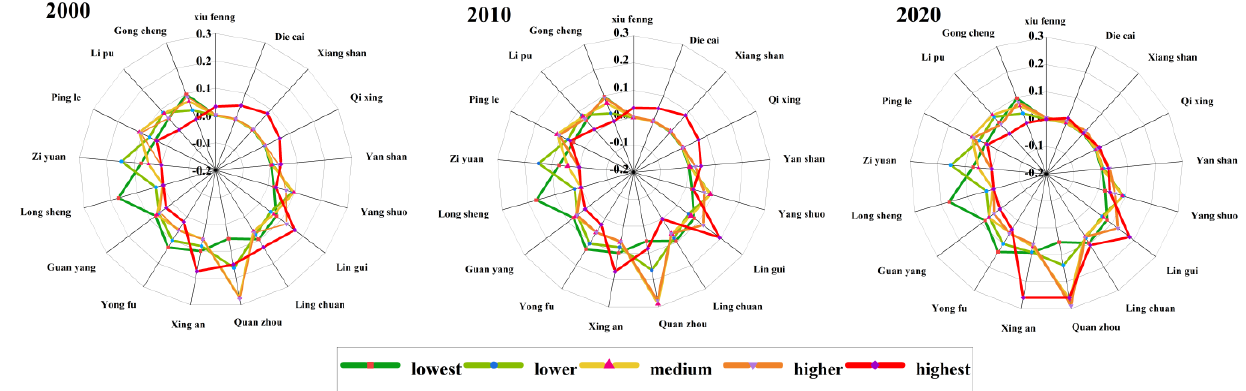
Figure 7. Ecological risk distribution in each district and county.